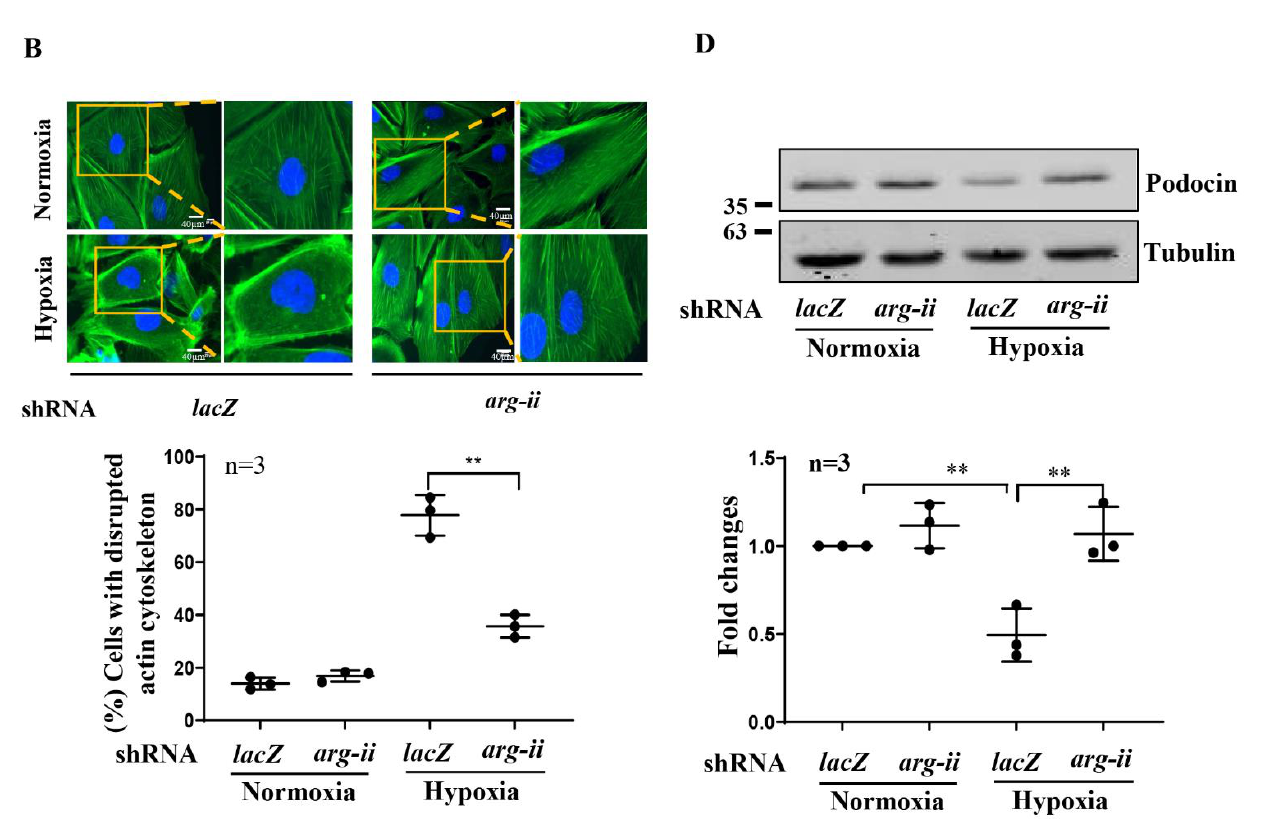
Figure 3. Silencing arg-ii in human podocytes attenuates hypoxia-induced cytoskeleton actin fiber derangement. ( A ) Representative immunoblotting results of Arg-II protein levels in different groups of podocytes. Tubulin serves as the loading control; n = 4. ( B ) Representative images showing phalloidin staining of cytoskeleton actin fibers in different groups of podocytes. Nucleoli were stained with DAPI (blue). Inserts illustrate a cell that represents the typical changes in cytoskeletal fibers under the indicated conditions. The graphics below show the quantification of podocytes with a disrupted cytoskeleton. n = 3. ( C ) Representative immunoblotting results show decreased podocin protein levels under hypoxic conditions; Tubulin serves as the loading control. The graphics below show the quantification of podocin signals. ( D ) Representative immunoblotting results show protective effects of arg-ii silencing on a hypoxia-induced decrease in podocin protein levels in podocytes. Tubulin serves as the loading control. The graphics below show the quantification of podocin signals. N: normoxia; H: hypoxia. * p < 0.05, ** p < 0.01, **** p < 0.001 between the